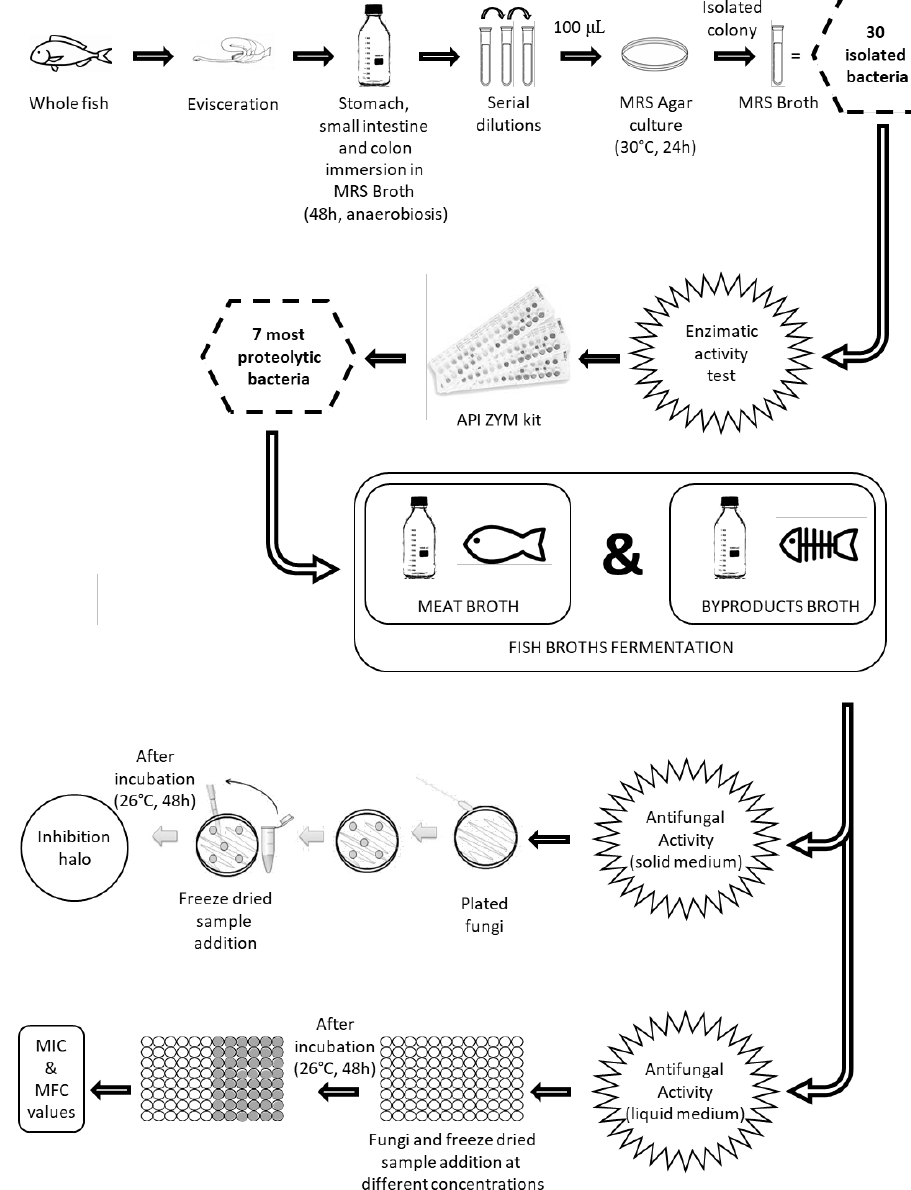
Figure 1. Schematic representation of the experimental set-up. MRS: Man, Rogosa & Sharp; MIC: Minimum Inhibitory Concentration; MFC: Minimum Fungicidal